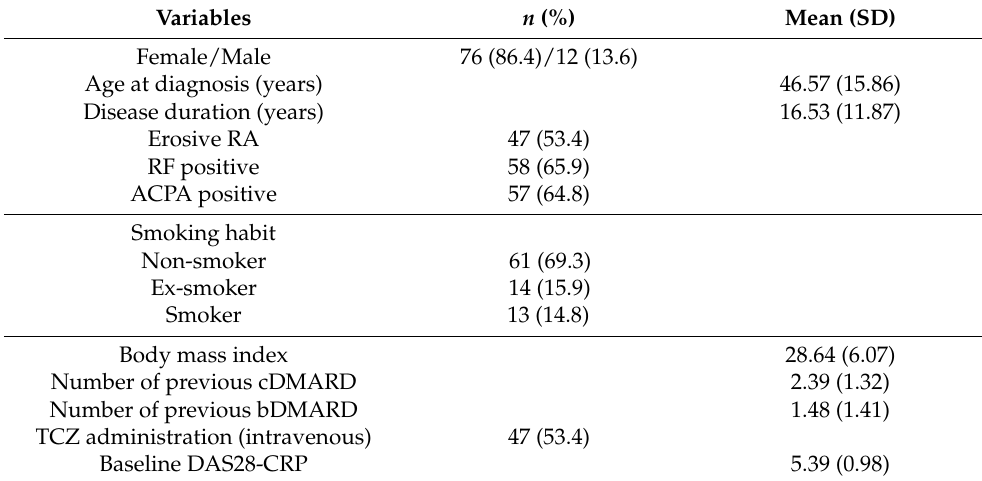
Table 2. Baseline patient characteristics ( n = 88).